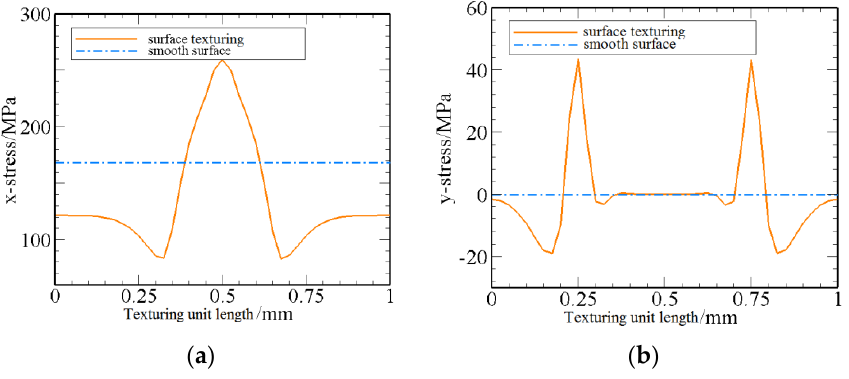
Figure 4. Stress distributions in interface A : ( a ) along the x directions; ( b ) along the y directions.